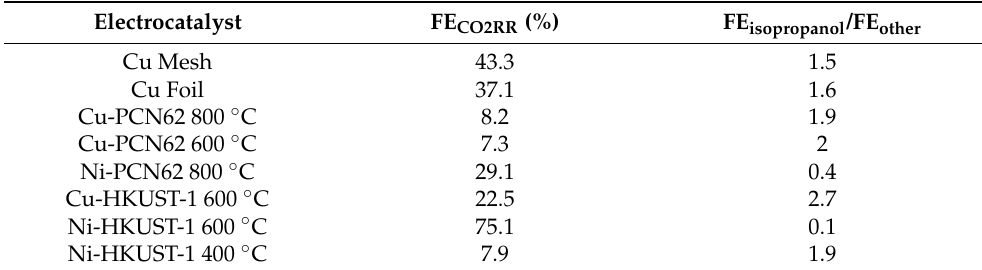
Table 6. The electrocatalytic performance of prepared catalysts for the CO 2 reduction reaction (CO 2 RR)